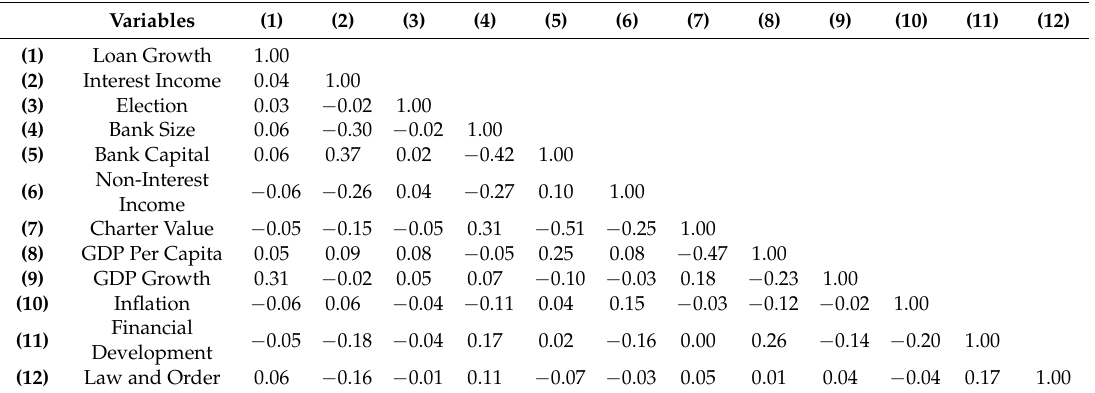
Table 3. Pairwise Pearson